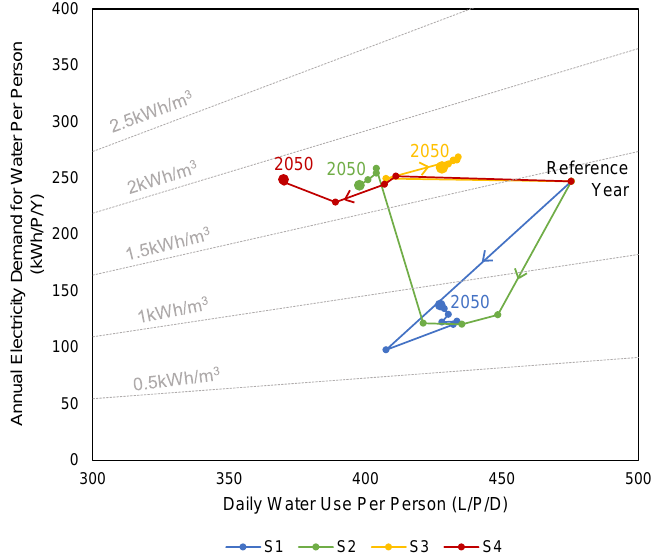
Figure 5. Annual electricity demand per person versus water use per person per day for the studied water supply scenarios for LADWP. The wedges indicate the total electricity demand intensity of water supply